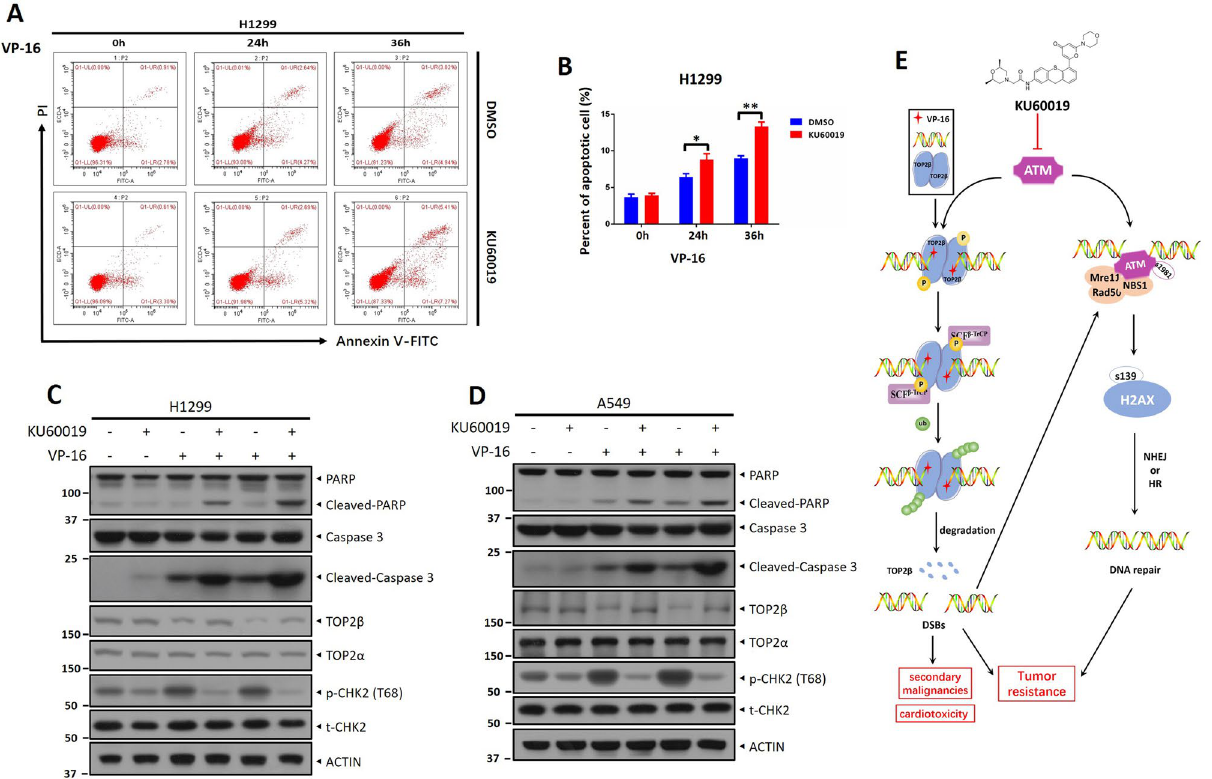
Figure 6. A combination of KU60019 and VP-16 promotes the apoptosis of lung cancer cells. ( A , B ) H1299 cells were treated with VP-16 (10 μM) alone or in conjunction with KU60019 (5 μM) for the indicated time periods and then subjected to FACS analysis to determine the apoptotic population. ( C , D ) H1299 and A549 cells were incubated with various concentrations of KU60019 or VP-16 for 24 h, followed by MK-2206 (0.5 or 1 μM) or DMSO for 24 h. Cells were harvested for western blotting using indicated antibodies. All experiments were independently repeated three times. According to the molecular weight, the nitrocellulose membrane was cut prior to hybridization with antibodies and the original blots are presented in Supplementary Fig. 5. Molecular weight markers are noted to the left of blot